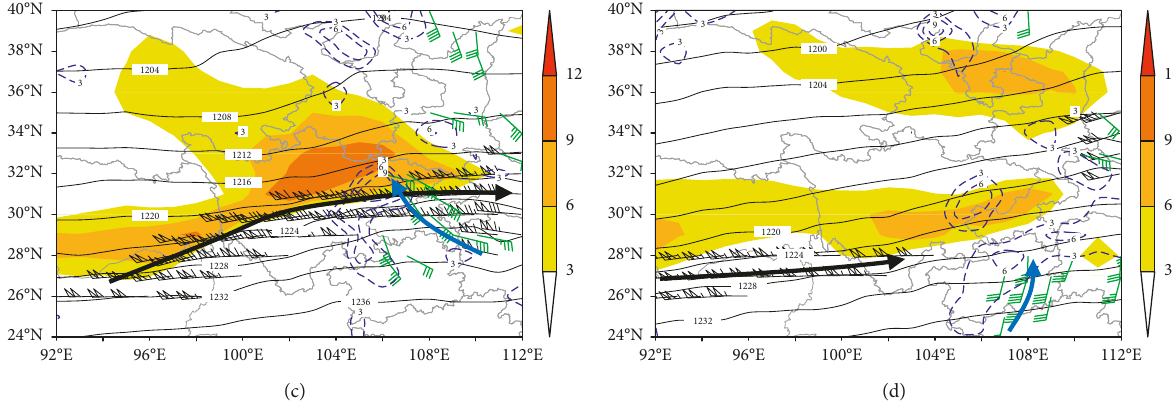
1 ), geopotential height (solid line, gpdam), and vorticity (shading, 10 s · 1 ) and vorticity (dotted line, 10 5 s 1 ), at (a) 0000 UTC 27 October 2014, (b) 0600 UTC 27 October 2014, (c) 1200 s − · − − −